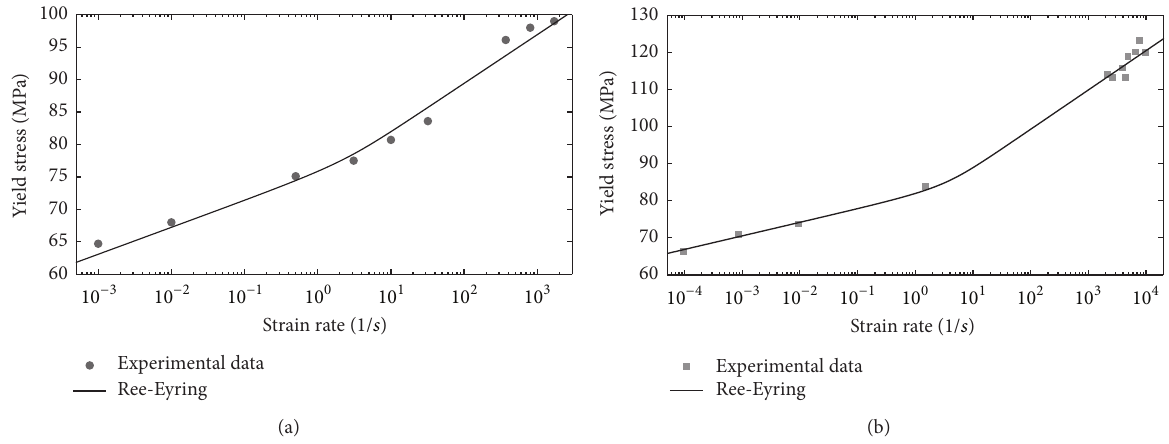
Figure 3: Experimental yield stress of PC fitted by the Ree-Eyring equation: (a) tension and (b) compression.